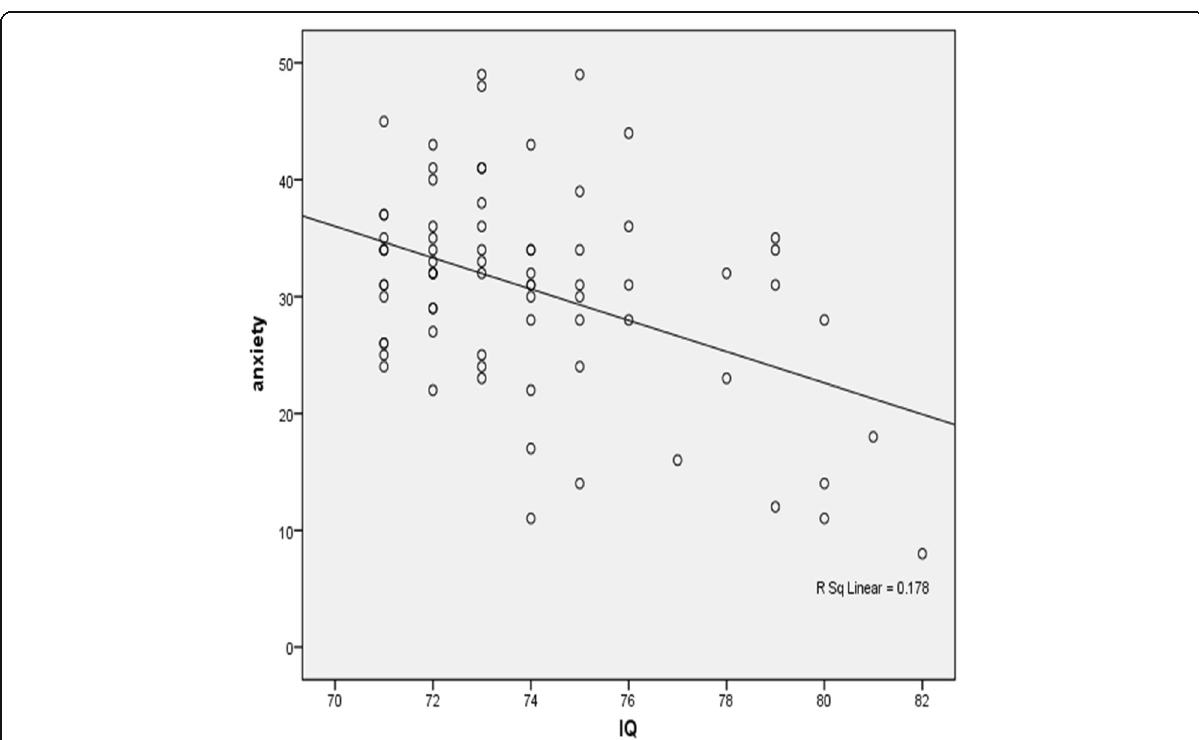
Fig. 6 Shows significant negative correlation between anxiety scores and intelligence quotient (IQ) total scores ( R = .422) of all children (the three groups A, B, and